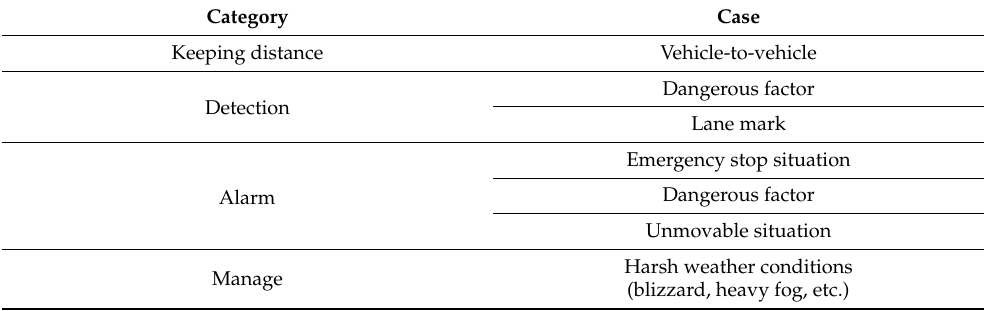
Table 10. Scenario selection—curve.